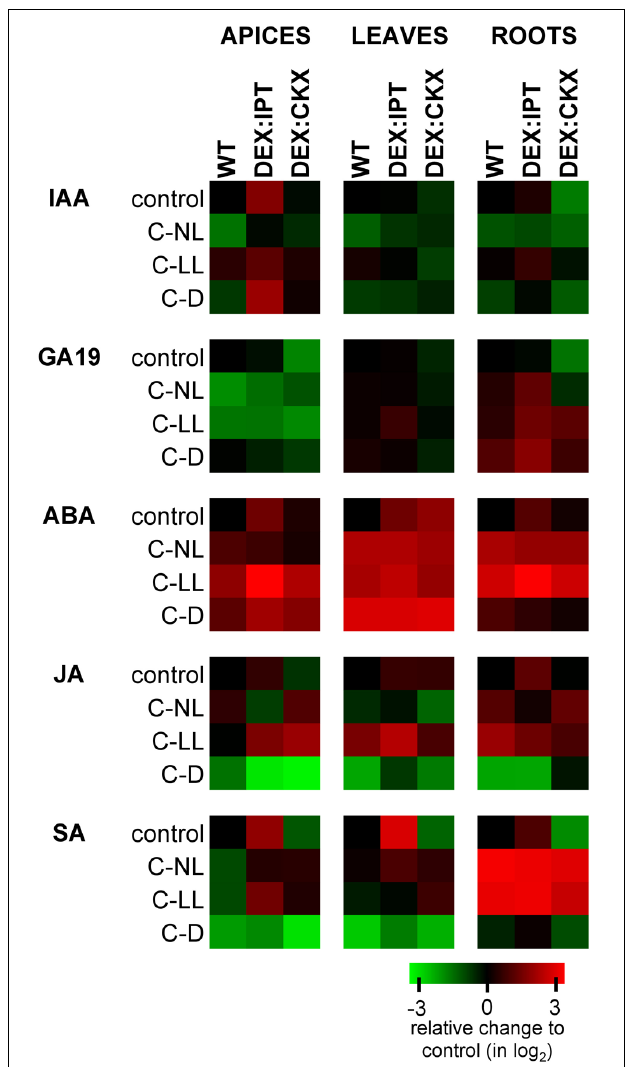
FIGURE 3 | The relative levels of phytohormones in apices, leaves, and roots of WT, DEX:IPT , and DEX:CKX plants expressed as a log 2 change of the ratio between the genotype under individual treatments and the WT under control conditions within each tissue separately. The expression of the transgenes was activated by dexamethasone (DEX). See Table 1 for the description of experimental variants. ABA, abscisic acid; SA, salicylic acid; JA, jasmonic acid; GA19, gibberellin GA 19 ; IAA, auxin indole-3-acetic acid. The means ± SD and detailed statistics of hormones are shown in Supplementary Table 2